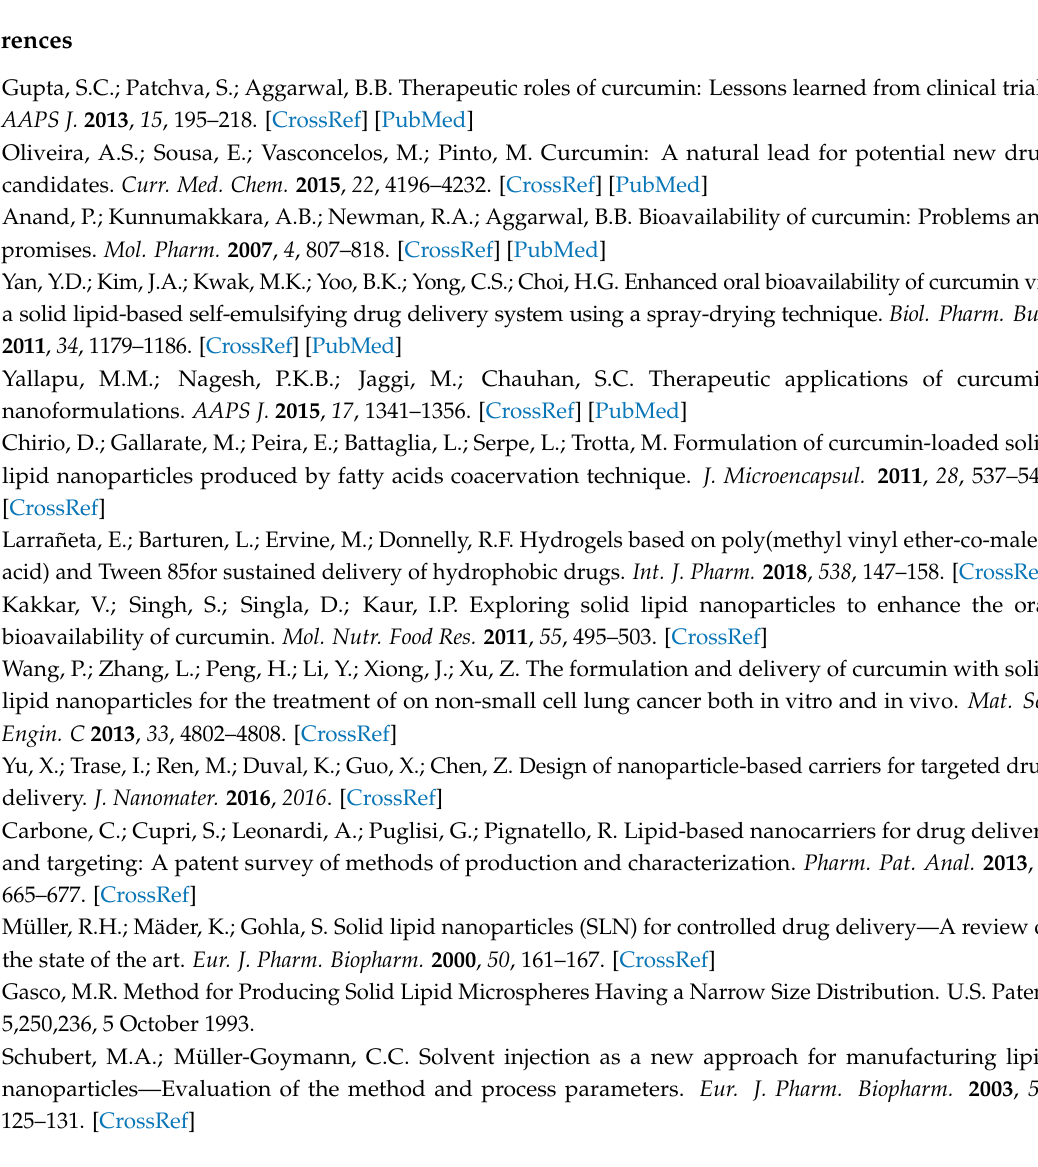
Figure S1: DSC thermograms of TL, CURC bulk material, and SLN-CURC after production and